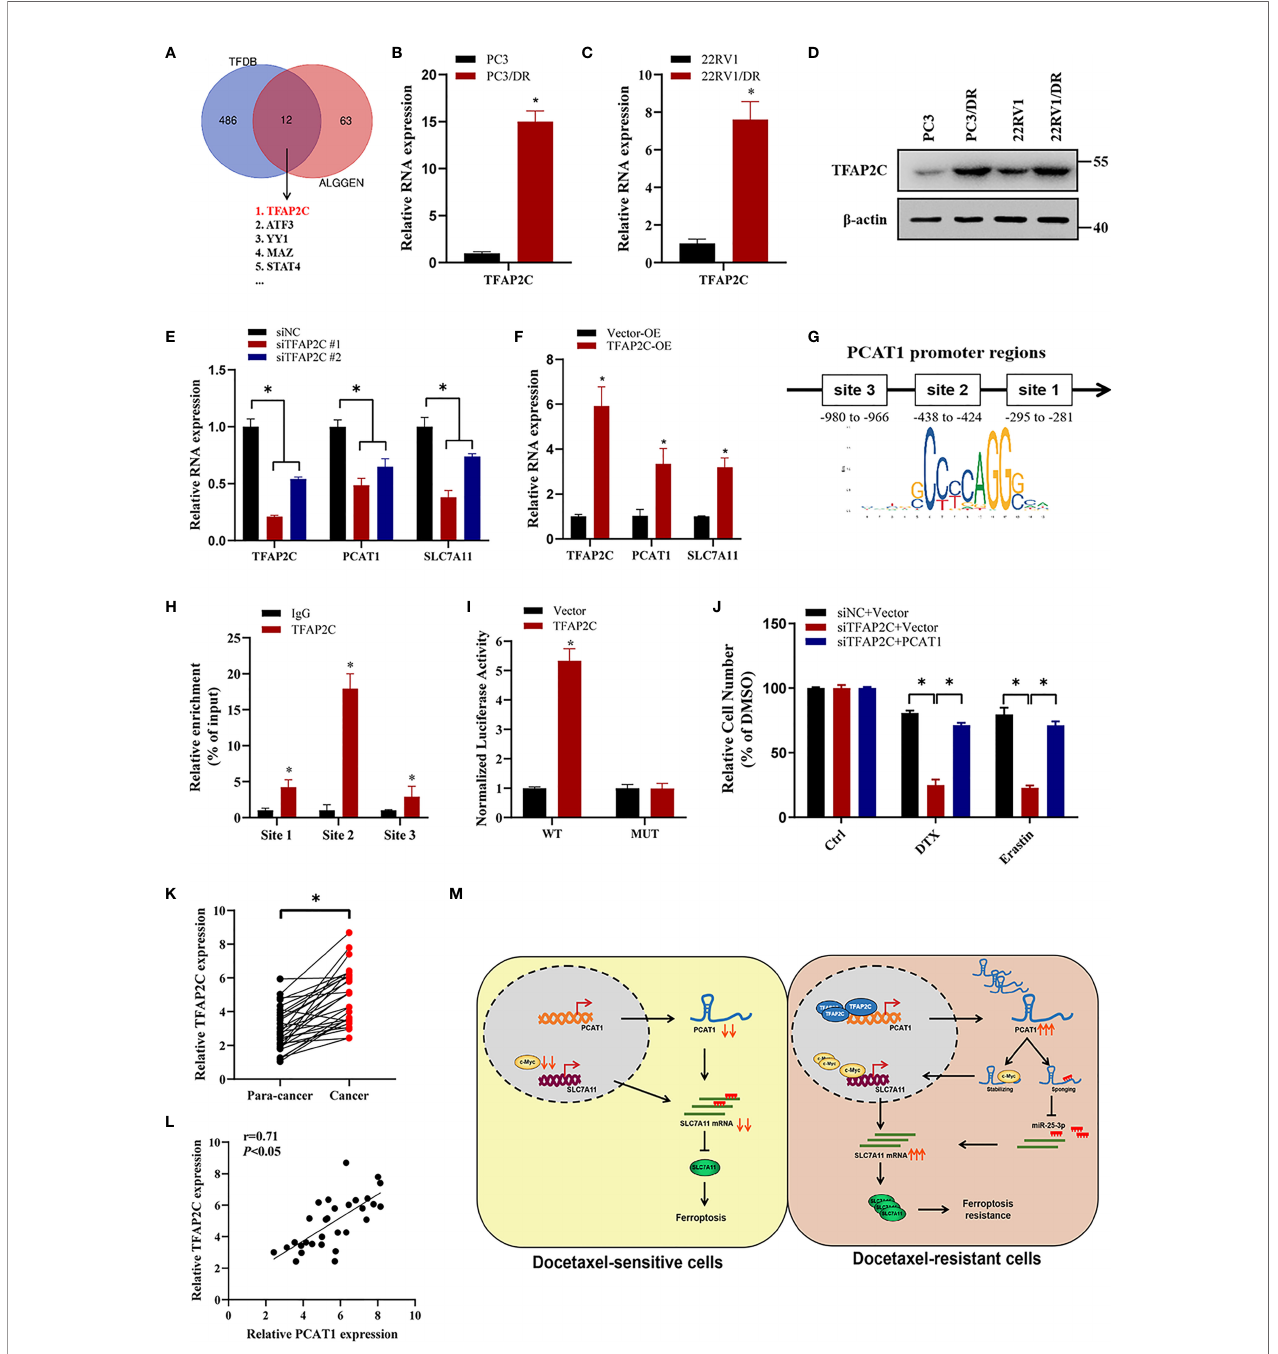
FIGURE 8 | TFAP2C transcriptionally activates PCAT1 expression in DTX-resistant cells. (A) Venn diagram showing the possible transcription factors within the promoter regions of PCAT1 by online bioinformatics analysis (HUMAN TFDB and ALGGEN). (B-D) The mRNA and protein levels of TFAP2C were detected by qRT- PCR and Western blot in DTX-resistant PCa cells and their sensitive cells. (E) The mRNA levels of TFAP2C, PCAT1 and SLC7A11 in PC3/DR cells were detected after transfected with siTFAP2C and control siRNA. (F) qRT-PCR assay was used to assess the expression of TFAP2C, PCAT1 and SLC7A11 in PC3 cells after TFAP2C overexpression. (G) Schematic diagram showing location of TFAP2C binding sites on the promoter regions of PCAT1. (H) ChIP-qPCR was used to detect the binding ef fi ciency of TFAP2C on the PCAT1 promoter. (I) The luciferase activities were measured in TFAP2C overexpressed PC3 cells after co-transfected with PCAT1 wild-type and mutant reporter plasmids. (J) Cell viability was assessed by CCK-8 assay in TFAP2C-knockdown PC3 cells after transfected with PCAT1 and vector plasmids. (K) The relative expression of TFAP2C was measured by qRT-PCR in 30 pairs of clinical PCa samples. (L) The positive relation between TFAP2C and PCAT1 in clinical samples (n=30) by qRT-PCR. (M) The schematic diagram showing that TFAP2C-induced PCAT1 inhibits ferroptosis in DTX-resistant PCa cells through c-Myc/miR-25-3p/SLC7A11 signaling. The data are presented as the mean±SD, * P